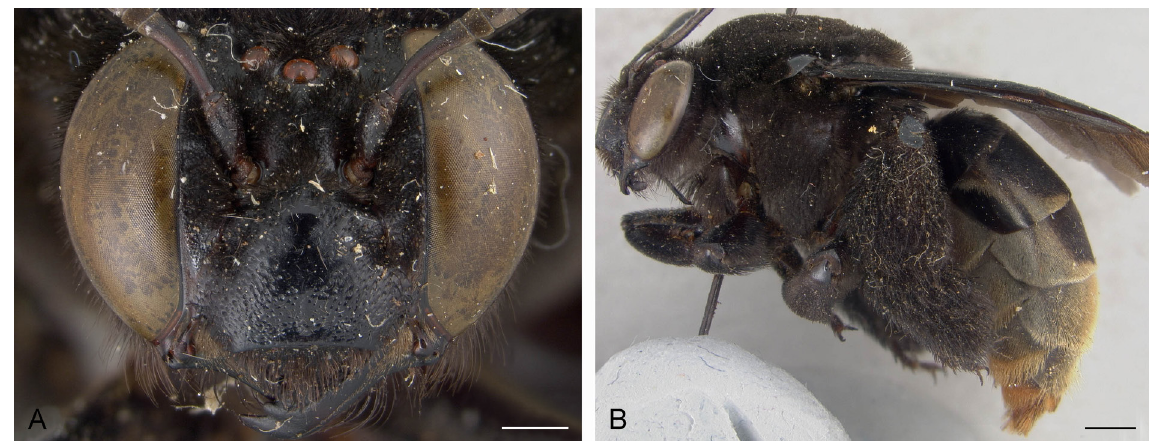
Fig. 20. Epicharis zamoranensis Cockerell, 1949, holotype, ♀ (NMNH; USNM ENT 00534219). A . Frontal view. B . Habitus, lateral view. Scale bars: A = 1 mm; B = 2